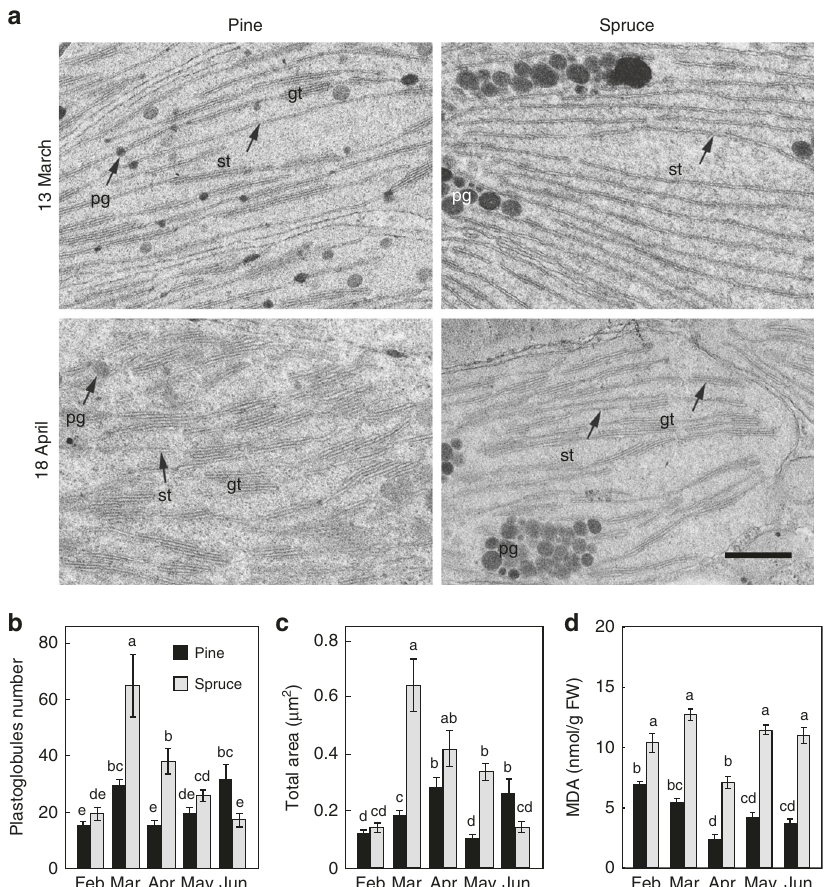
Fig. 2 The chloroplasts in Norway spruce are more sensitive to photodamage during the spring recovery period compared with the chloroplasts in Scots pine. a Transmission electron micrographs (TEM) of chloroplast structures in needles from Scots pine and Norway spruce collected in the fi eld during March and April. Representative images are shown. Bar: 0.5 μ m. gt grana thylakoid (stacked), st stromal thylakoid (unstacked), pg plastoglobulus. The TEM images from the remaining months are found in Supplementary Fig. S1. The number ( b ) and total area ( c ) of plastoglobules per chloroplast from the transmission electron micrographs from Scots pine (black) and Norway spruce (gray, mean ± SE, n = 8 – 12). d Malondialdehyde (MDA) content in Scots pine (black) and Norway spruce (gray) needles. Samples were collected from February to June, and each data point represents the mean of four replicates (mean ± SE, n = 4). Signi fi cant differences were indicated with different letters above the bars (one-way ANOVA, P <